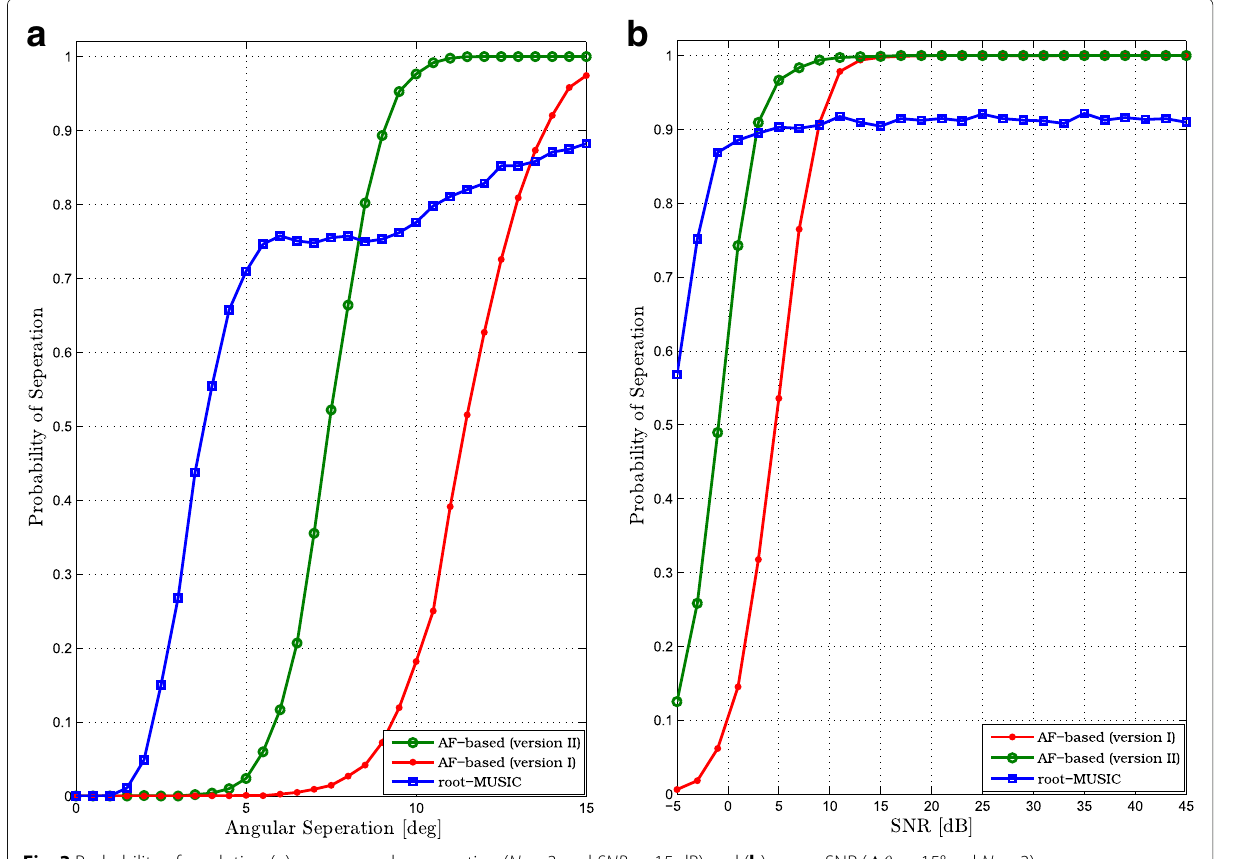
Fig. 3 Probability of resolution ( a ) versus angular separation ( N = 3 and SNR = 15 dB) and ( b ) versus SNR ( (cid:9)θ = 15°and N = 3)